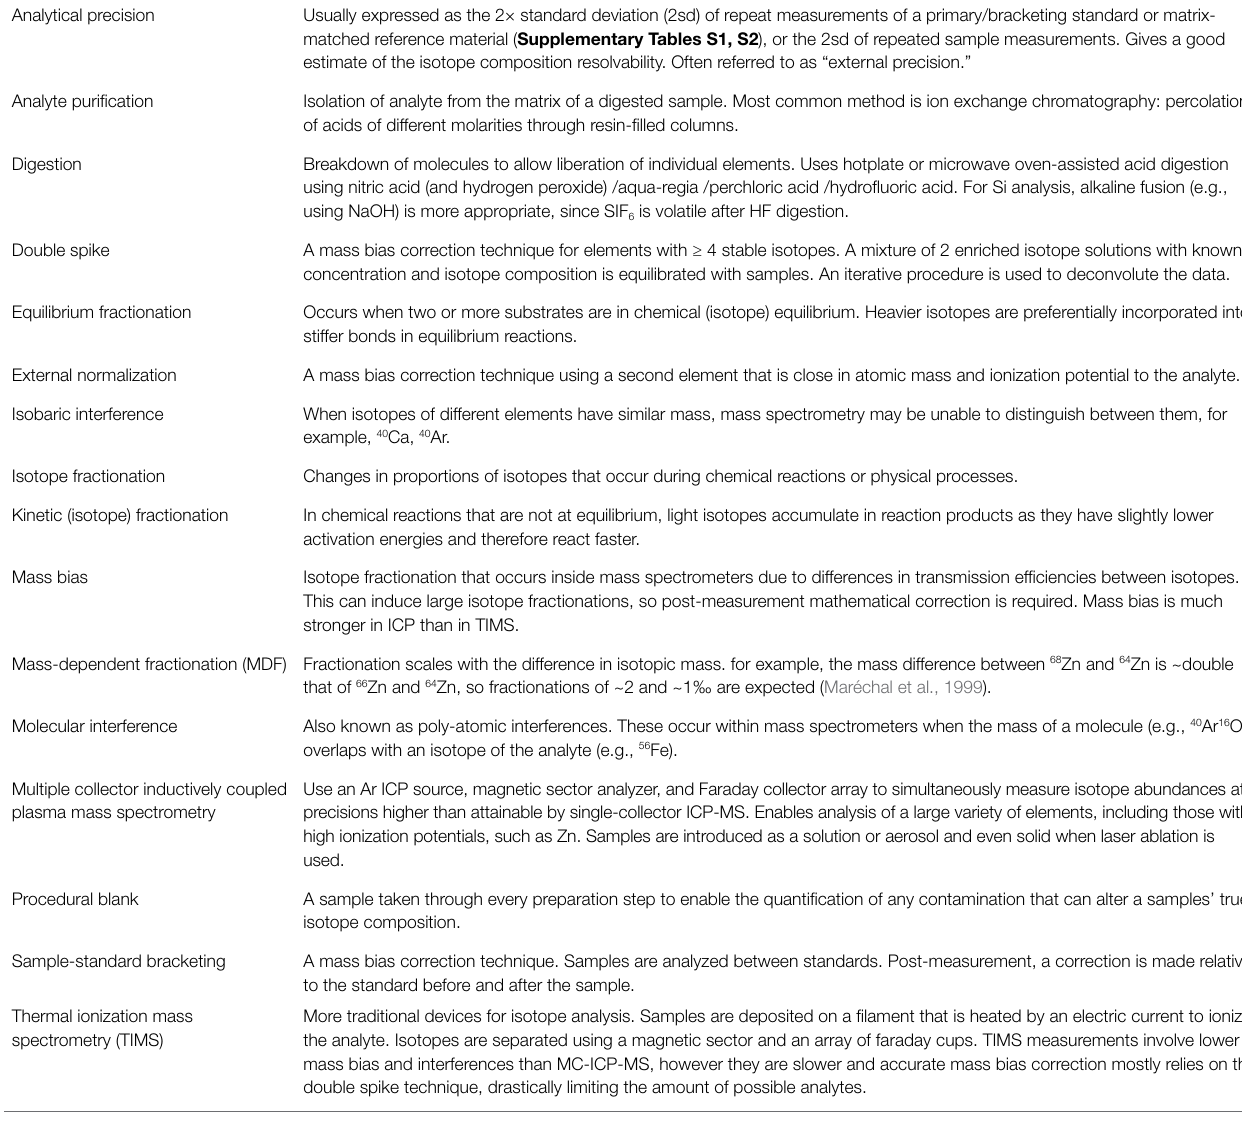
TABLE 1 | Glossary of terms relevant to isotope composition